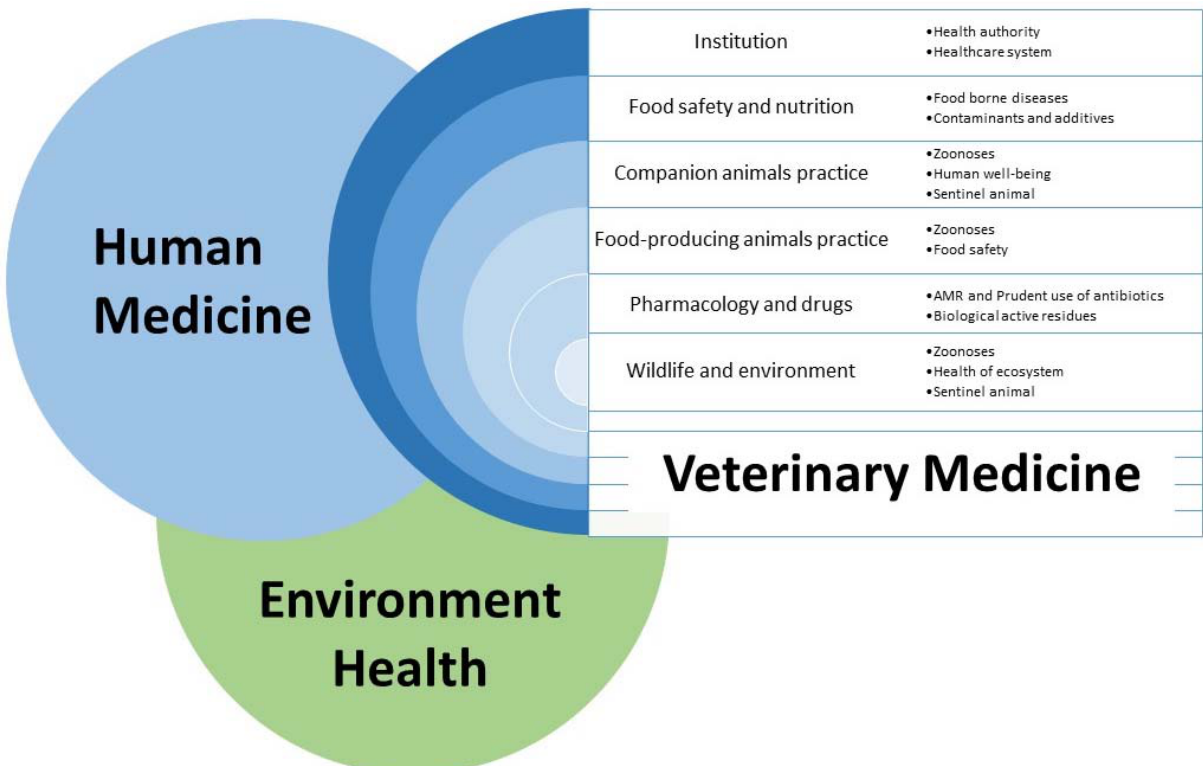
Figure 1. Potential contributes of veterinary medicine to public health in a One Health and One Communication